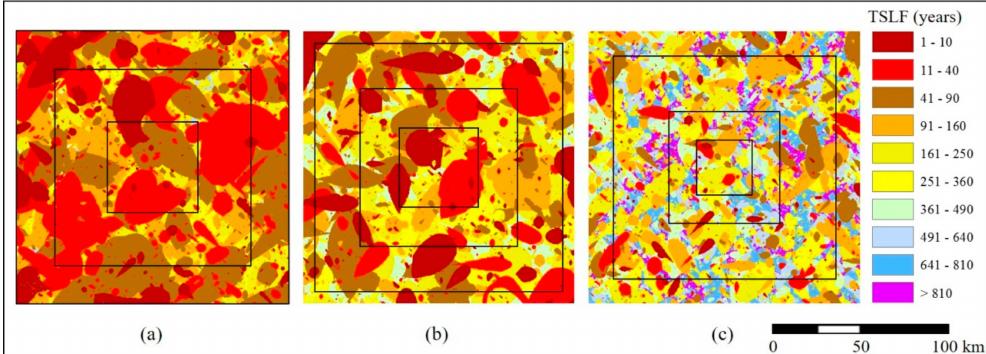
Figure 3. TSLF maps for the whole 2100 × 2100 grid simulated landscape created using ( a ) 1200 fire-year maps including all 200 Class 1 fire-year maps, ( b ) 1100 fire-year maps including 100 Class 1 fire-year maps, and ( c ) 1000 fire-year maps including no Class 1 fire-year maps. Outlined in black are the study area scales ( a ) 6 × , 3 × , 0.75 × , ( b ) 5 × , 2 × , 0.5 × , ( c ) 4 × , 1 × , 0.25 ×